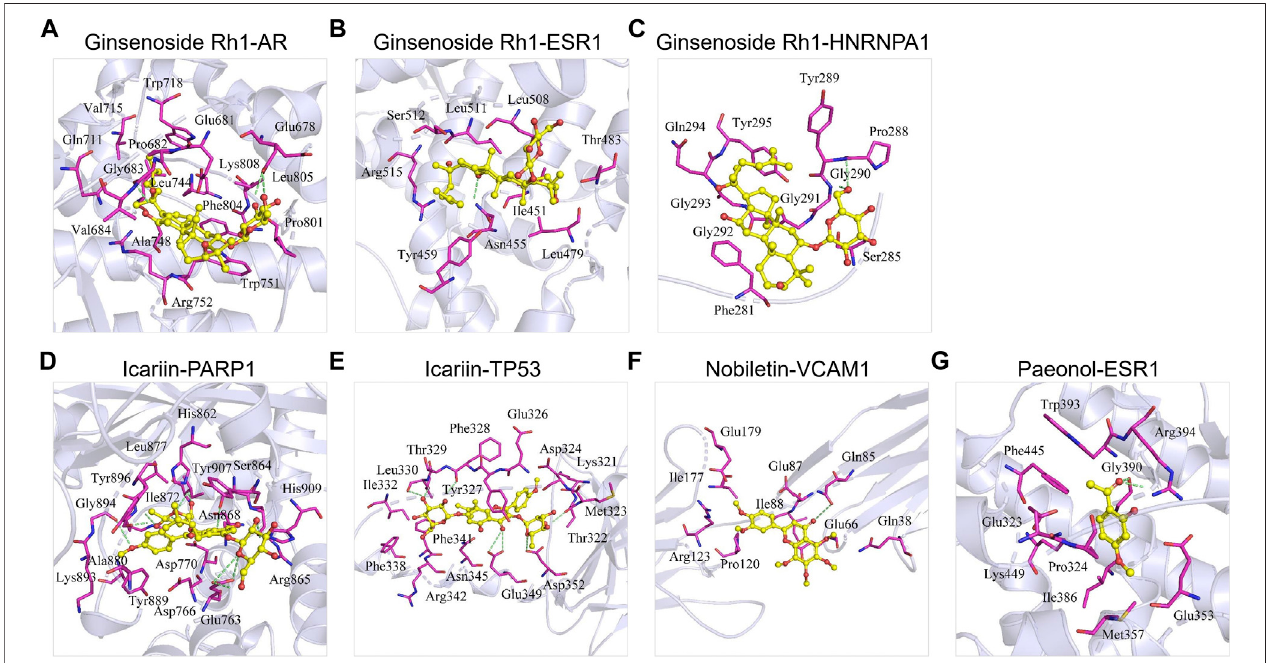
FIGURE 5 | Molecular docking of ECC compounds with their targets. The binding poses of (A) ginsenoside Rh1 and AR, (B) ginsenoside Rh1 and ESR1, (C) ginsenoside Rh1 and HNRNPA1, (D) icariin and PARP1, (E) icariin and TP53, (F) nobiletin and VCAM1, and (G) paeonol and ESR1.